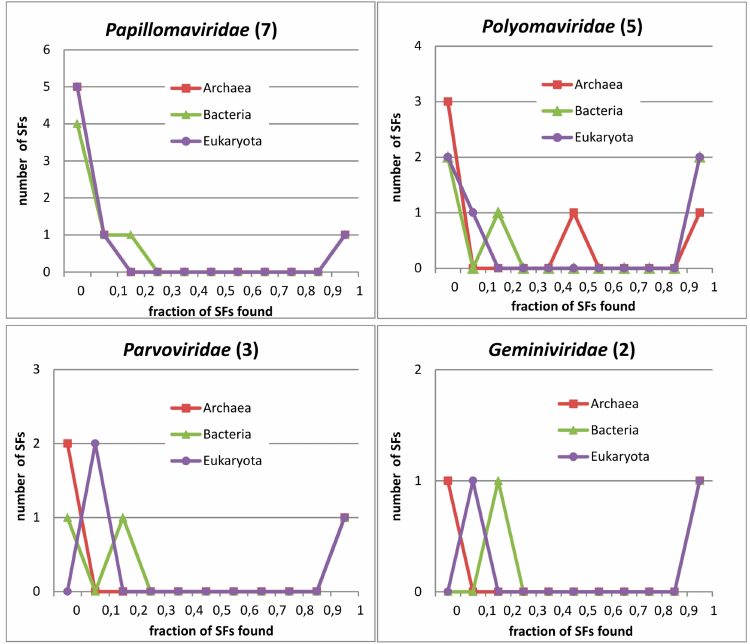
Figure 3. Distribution of protein domains in viral families by superkingdoms. Each figure shows data for the corresponding viral family. The number in the parentheses on titles corresponds to the number of distinct domains (SF) found in the respective viral family. The y -axis shows the number of domains (SF) from the viral family, covered by any of the three superkingdoms. The x -axis shows the decile of the genomes where the viral protein domains are found by superkingdoms. In panel Papillomaviridae , the lines for Archaea and Eukaryota